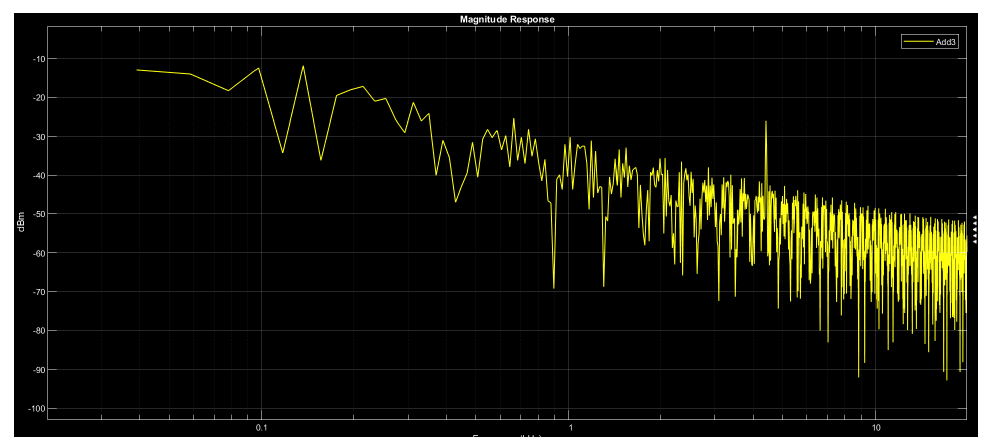
Figure 1. Digital filter model.